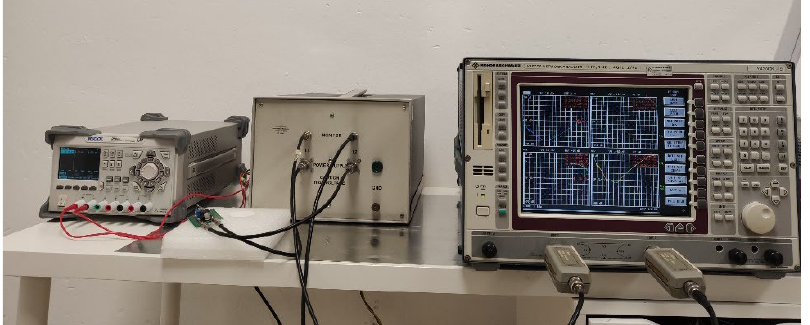
Figure 8. S-parameters measurement setup, which contains a EUT (front row, left side, placed above the foam), a VNA (right side) connected to two transient limiters, a two-port LISN (background, middle) and a programmable DC power supply (background, left side).